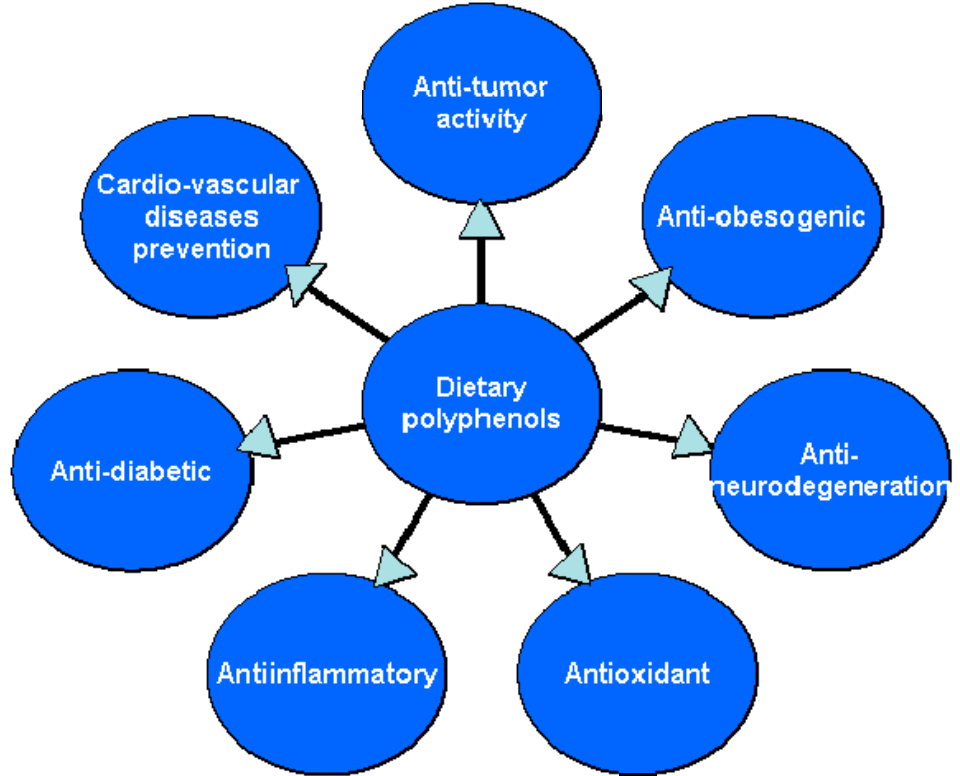
Figure 2. Biological properties of dietary polyphenols important in lifestyle diseases prevention.